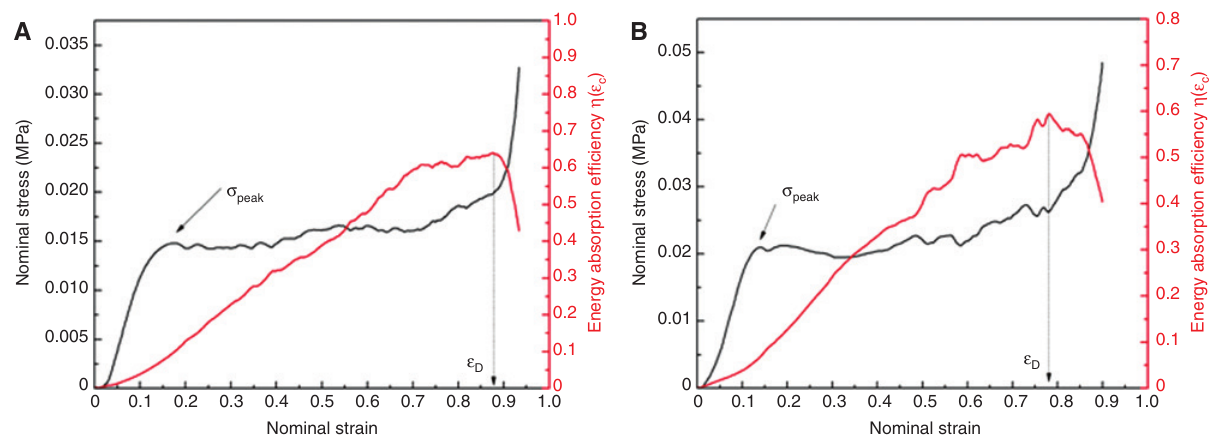
-direction (A) and 1